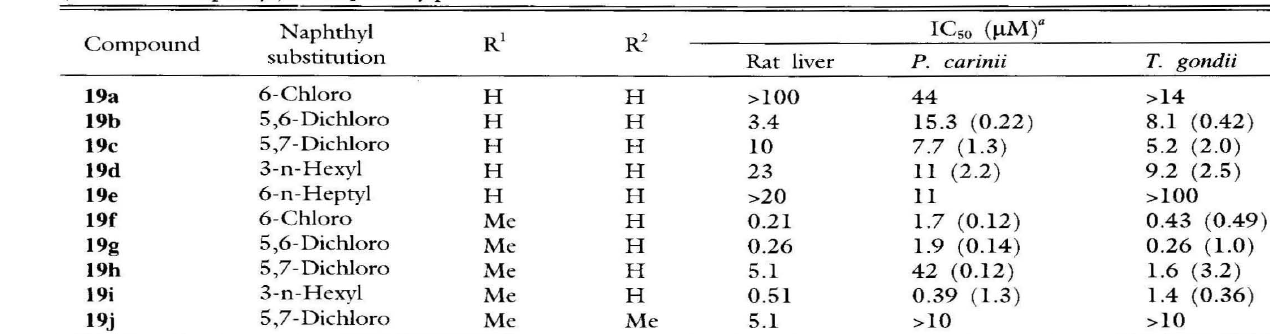
Table 2. Inhibition of DHFR from Rat Liver, Pneumocystis carinii, and Toxoplasma gondii by 2,4-Diamino-6-[2- (substituted naphthyl )amino] methylpteridines Naphthyl Rl R2 ICso (/l-M)" Compound